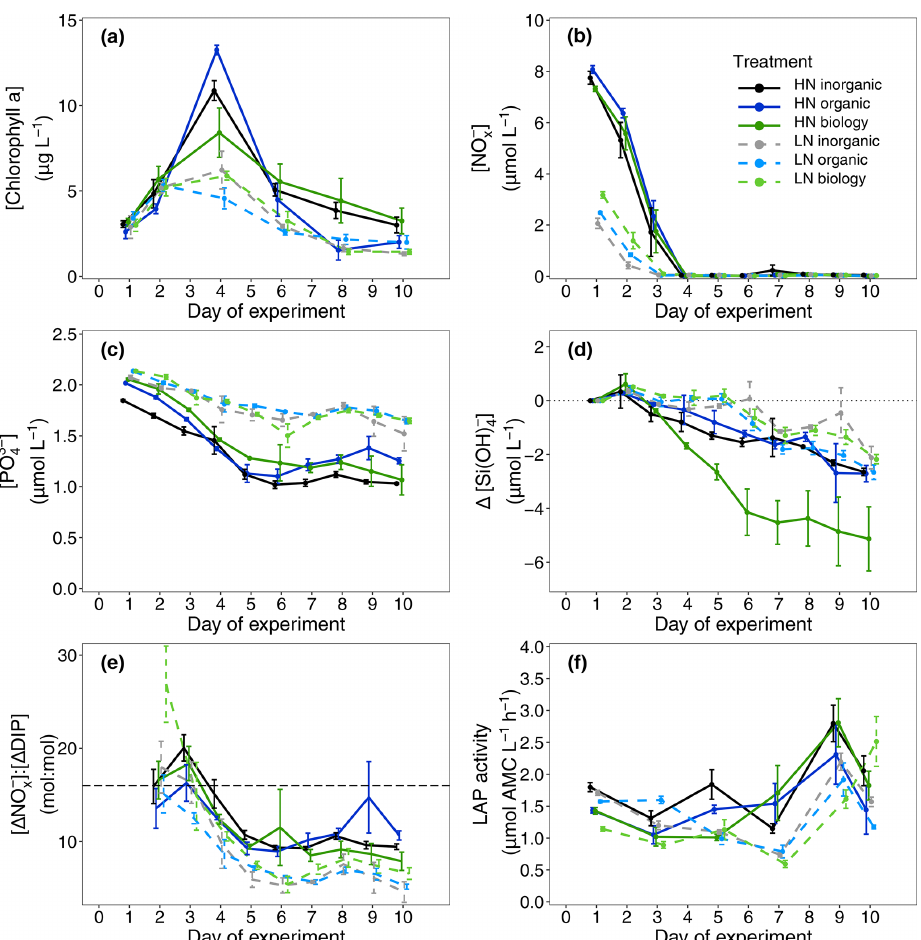
Figure 2. Measured (a) chlorophyll a concentrations, (b) nitrate + nitrite (NO x ) concentrations, (c) phosphate concentrations, (d) silicate drawdown relative to initial concentrations on Day 1 (Eq. 2), (e) calculated nutrient drawdown stoichiometry (nitrate + nitrite consumed vs. phosphate consumed, Eq. 1) and (f) measured leucine aminopeptidase (LAP) activity over the 10d study period. Dots indicate the means across four replicate incubations and the error bars indicate the corresponding calculated 95% confidence interval for each sampling day. The dashed line in (e) indicates the Redfield ratio of 16 :